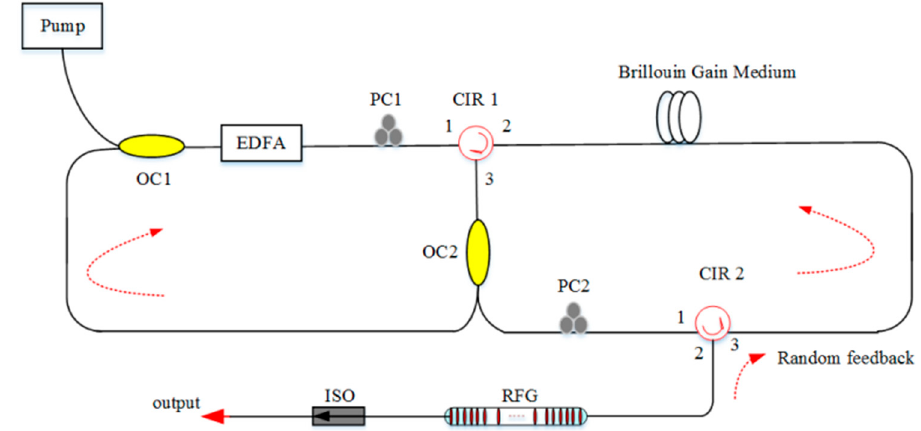
Figure 16. Experimental setup of RFL. OC, optical coupler; CIR, circle.